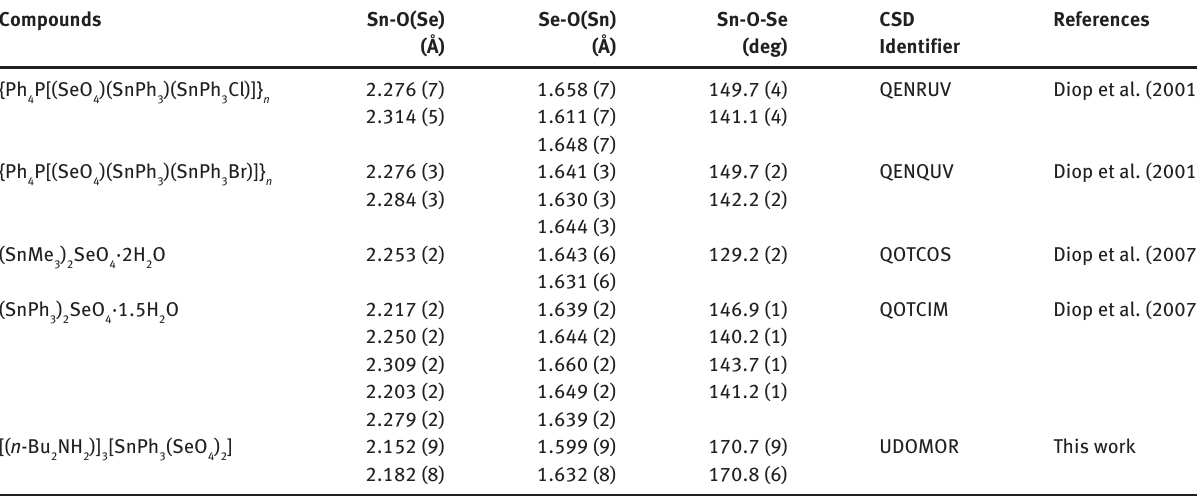
Table 2 Comparison of Sn-O(Se), Se-O(Sn) bond lengths (Å), and Sn-O-Se angles (deg) in selenato tin(IV) complexes.